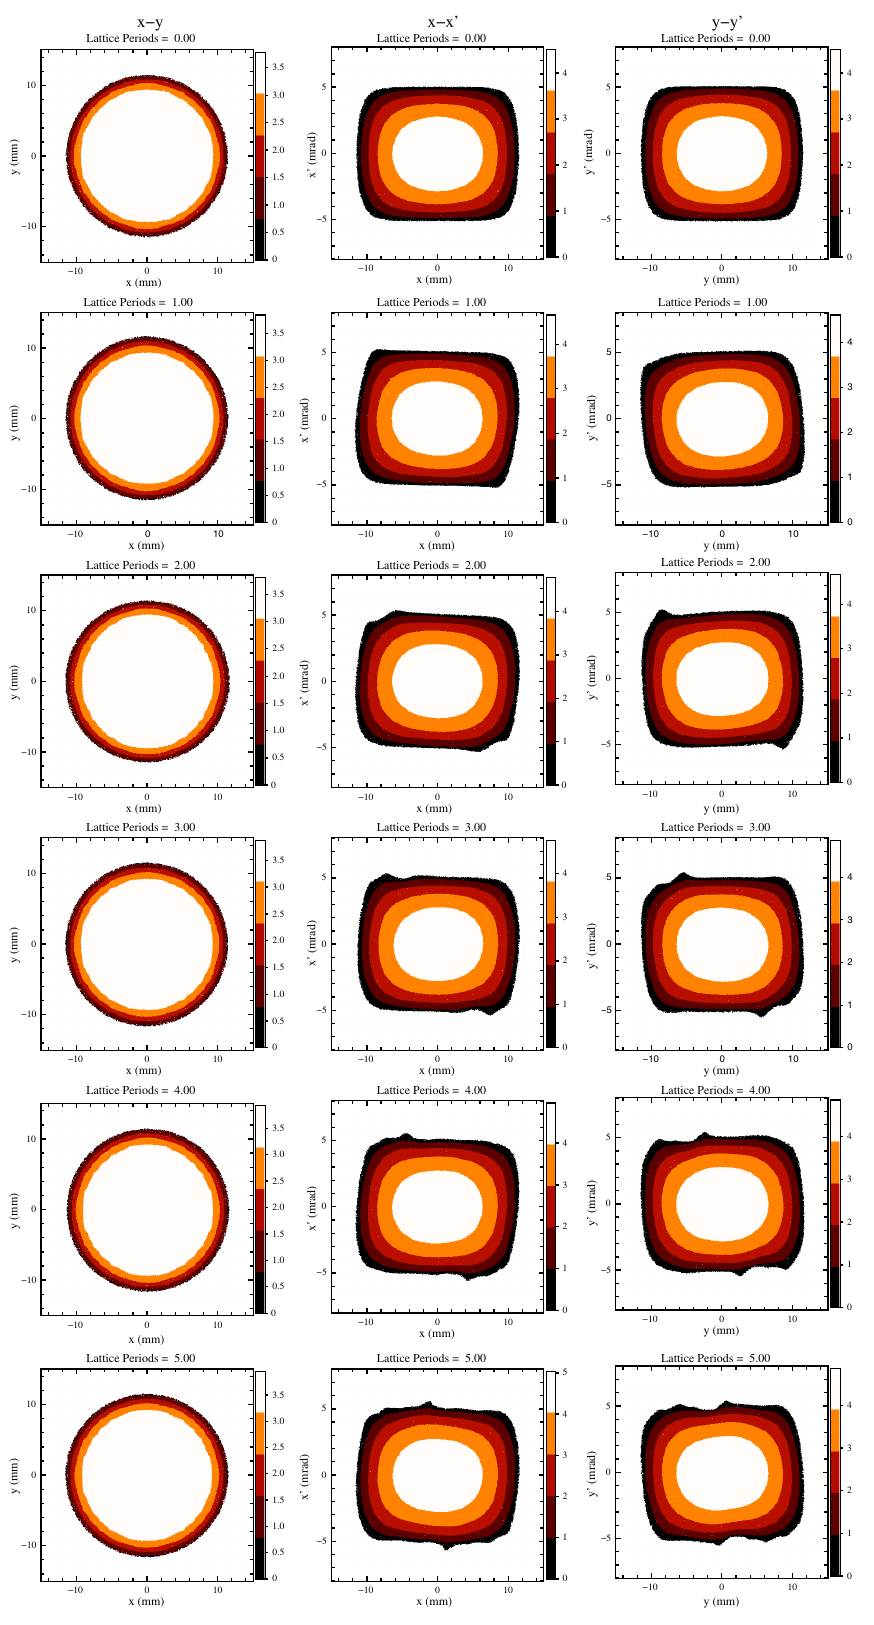
FIG. 9. (Color) Evolution in phase-space projections in x - y , x - x 0 , and y - y 0 for the initial pseudoequilibrium waterbag distribution ¼ 70 (cid:5) and (cid:3)=(cid:3) ¼ 0 : 2 . Projections (columns) are shown at lattice period intervals simulation shown in Figs. 6 and 7 with (cid:3) 0 0